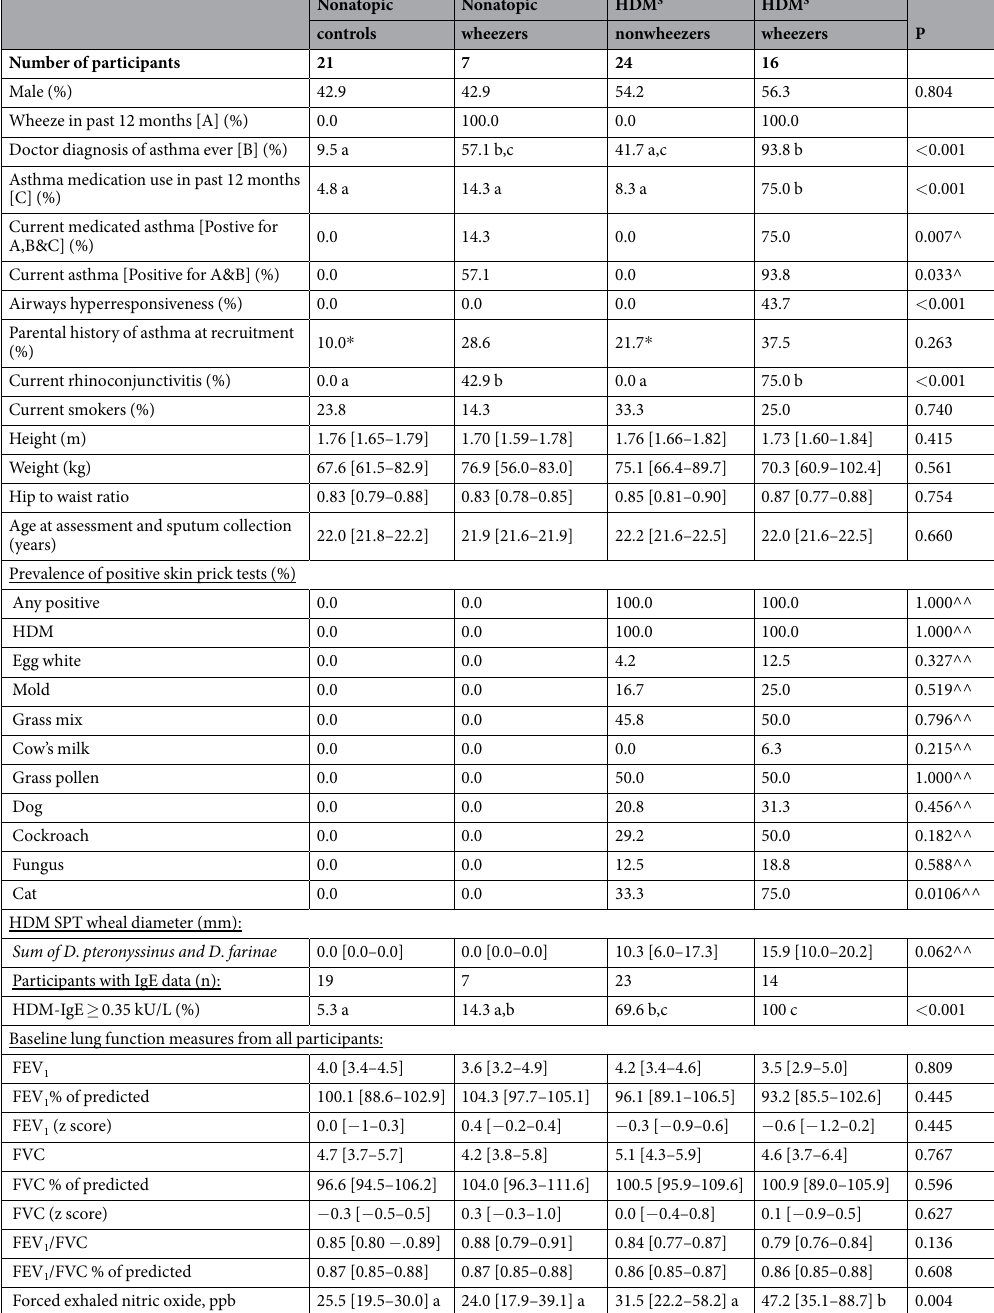
Table 1. Characteristics of the study population. Median [interquartile range] is displayed for all continuous measures. P value is derived from analyses comparing the four groups: prevalence values were compared by Chi square analysis; continuous measures were compared by Kruskal Wallis analysis. Where significant differences were observed between the four group groups (P < 0.05 in table), each letter denotes sputum groups that do not differ significantly at the 0.05 level after adjusting for multiple pair-wise comparisons (e.g. a vs a = not significantly different, a vs b = significantly different). * Data was missing for 1 participant in each group. ^Wheezing groups only were compared by Mann Whitney U test. ^^Atopic groups only were compared by Chi square (IgE binary variables) or Mann Whitney U test (SPT wheal diameter). Skin prick test were classified positive if wheal diameter was ≥ 3 mm. Baseline spirometry data are reported in absolute terms, in addition to z score and predicted terms that were calculated using the 2012 Global Lung Function Initiative equations 72